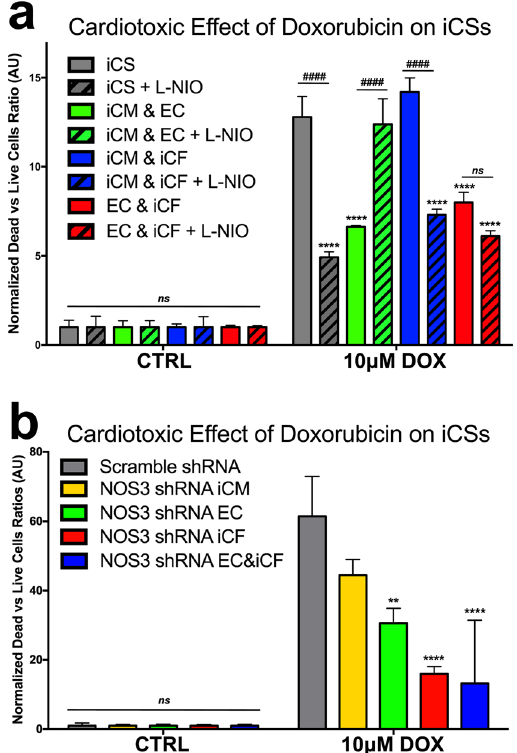
Figure 6. DOX toxicity is mediated via NOS in different cell types. ( a ) Comparison of DOX-mediated toxic effects in co-cultures from different cell populations ( n = 6): (i) iCS generated from iCM, EC and iCF; (ii) iCMs combined with ECs only; (iii) iCMs combined with iCFs only; and iv) ECs combined with iCFs. 100 μ M L-NIO was used to inhibit NOS activity. Two-way ANOVA followed by Tukey’s multiple comparisons test. F (df 7, 32) = 17.13. ( b ) Comparison of DOX-mediated toxicity in iCSs where eNOS was inhibited by using eNOS shRNA in specific cell types ( n = 6). Scramble shRNA was used as control. * Relative to iCS; ♯ within the same cell population. Data are presented as mean ± SEM. Two-way ANOVA followed by Tukey’s multiple comparisons test. F (df 4, 40) =